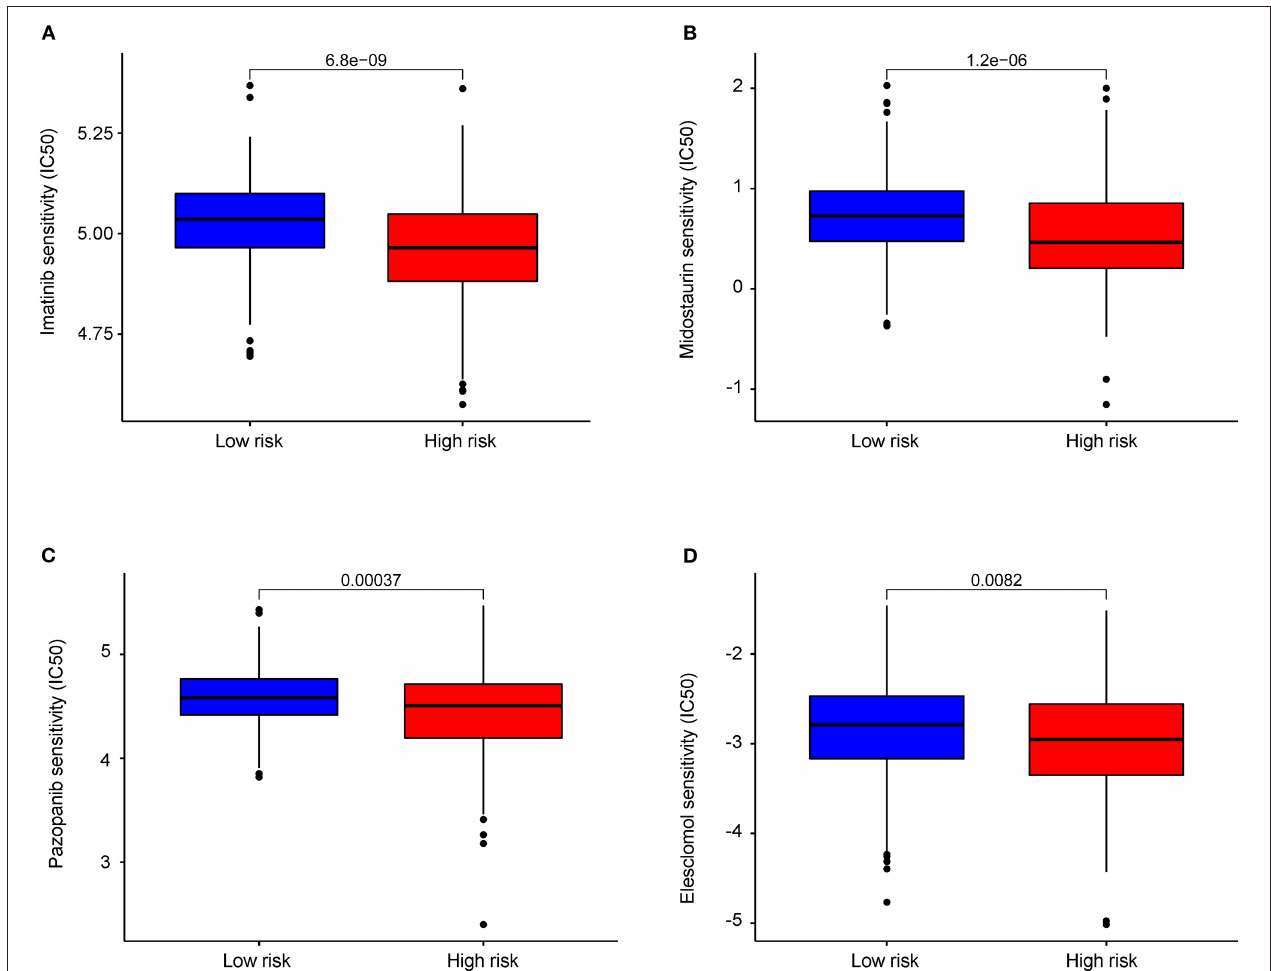
FIGURE 8 | Differential chemotherapeutic response based on IC50 between the high- and low-AAMRGs-risk groups. (A–D) The half-maximal inhibitory concentration (IC50) of 4 chemotherapeutic agents (imatinib, midostaurin, pazopanib and